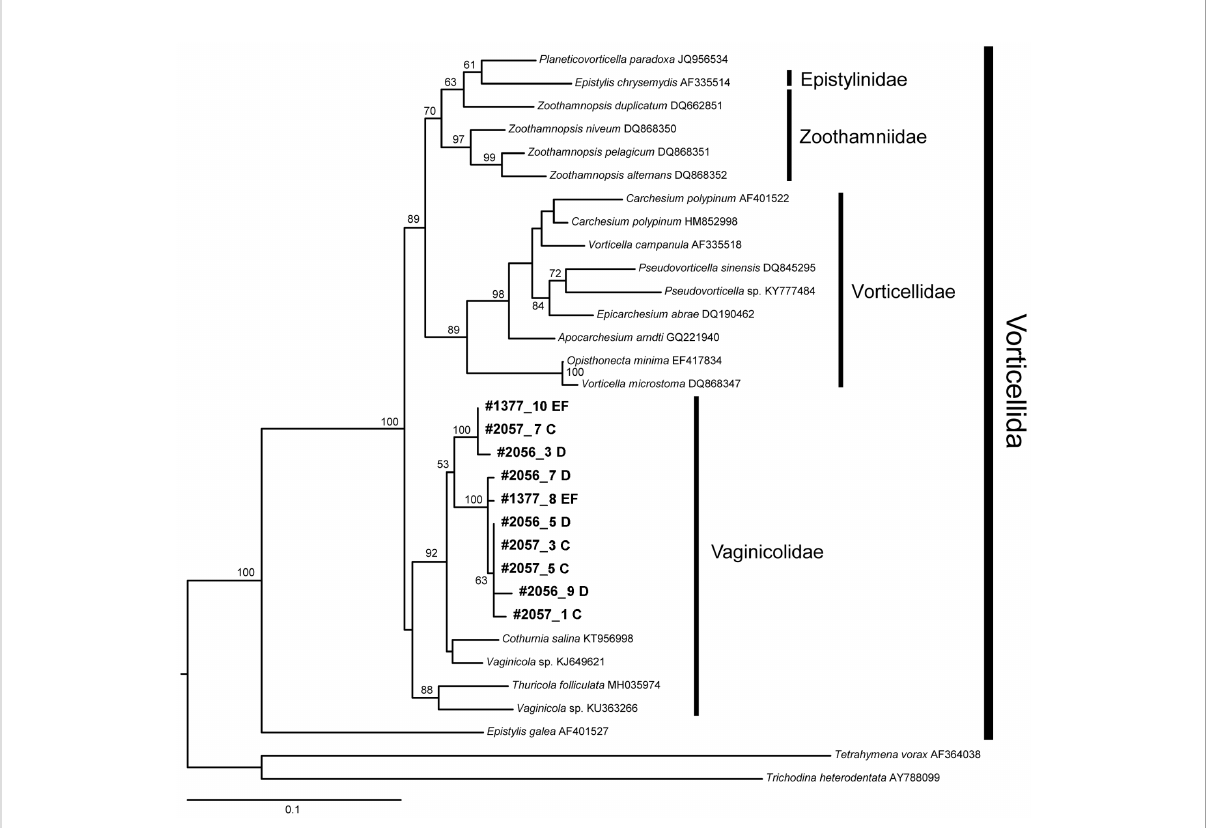
FIGURE 12 Maximum likelihood tree showing the placement of our Vaginicolidae sequences in the context of Vorticellida ciliates. Leaves corresponding to our sequences are in bold. Branch numbers show bootstrap support above 50. The tree is rooted with the distantly related Tetrahymena vorax . Scale bar, 0.1% sequence